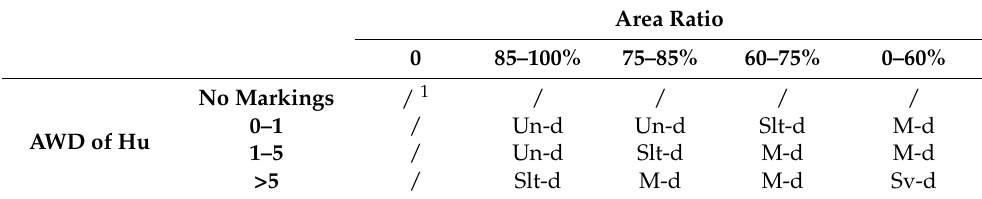
Table 2. The discriminant matrix of assessment on arrow-type marking defects.